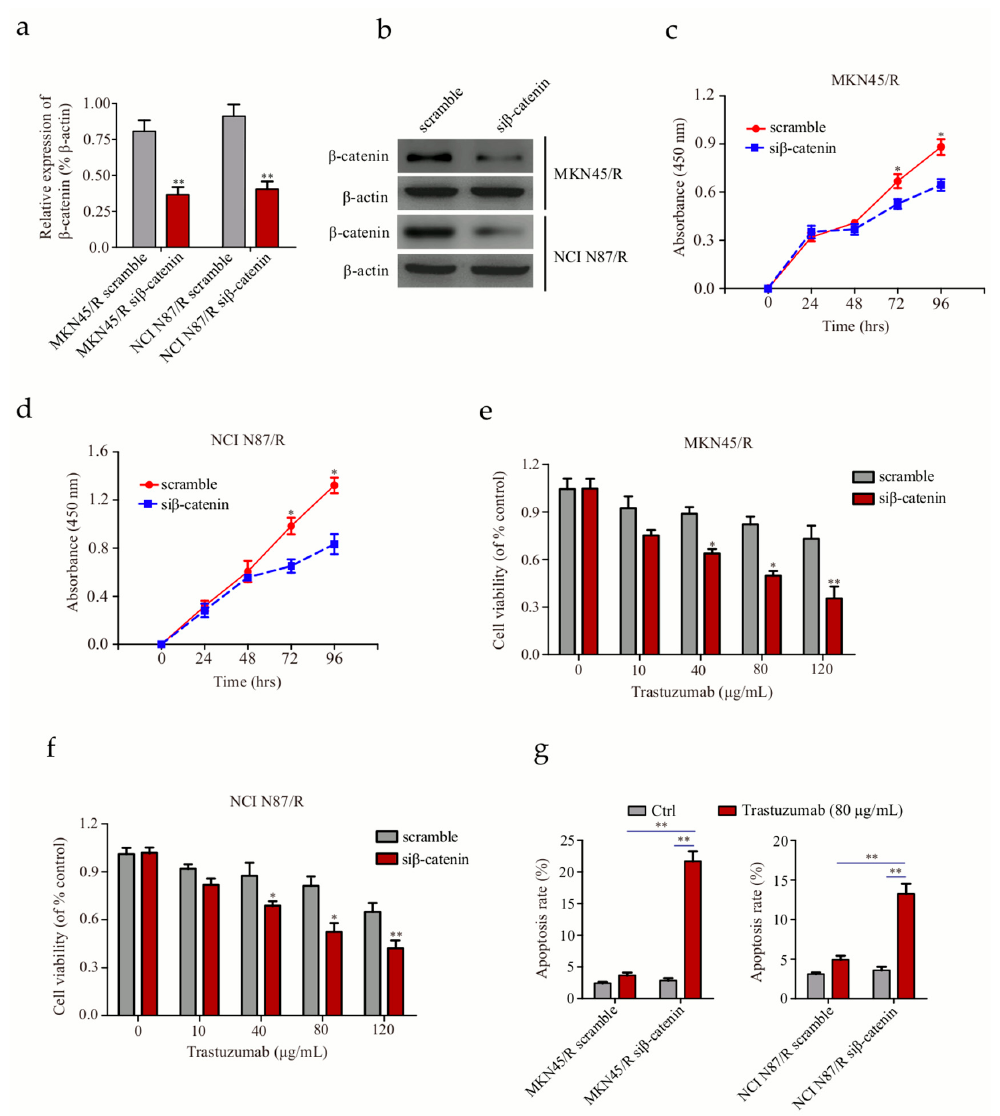
Figure 7. Knockdown of β -catenin enhances the sensitivity of trastuzumab-resistant gastric cancer cells to trastuzumab ( a , b ) Evaluation of β -catenin knockdown in trastuzumab-resistant MKN45 and NCI N87 cells by real time-polymerase chain reaction (RT-PCR) and Western blot respectively; ( c , d ) Knockdown of β -catenin via small interfering RNA (siRNA) targeting β -catenin (si β -catenin) decreased proliferation of MKN45/R and NCI N87/R cells; ( e , f ) Knockdown of β -catenin induced a decrease of living cells after trastuzumab treatment; ( g ) Detection of cell apoptosis by Annexin V/PI staining upon treatment with 80 μ g/mL trastuzumab for 96 h. All data represent three independent experiments. * p < 0.05, ** p < 0.01 vs. control.